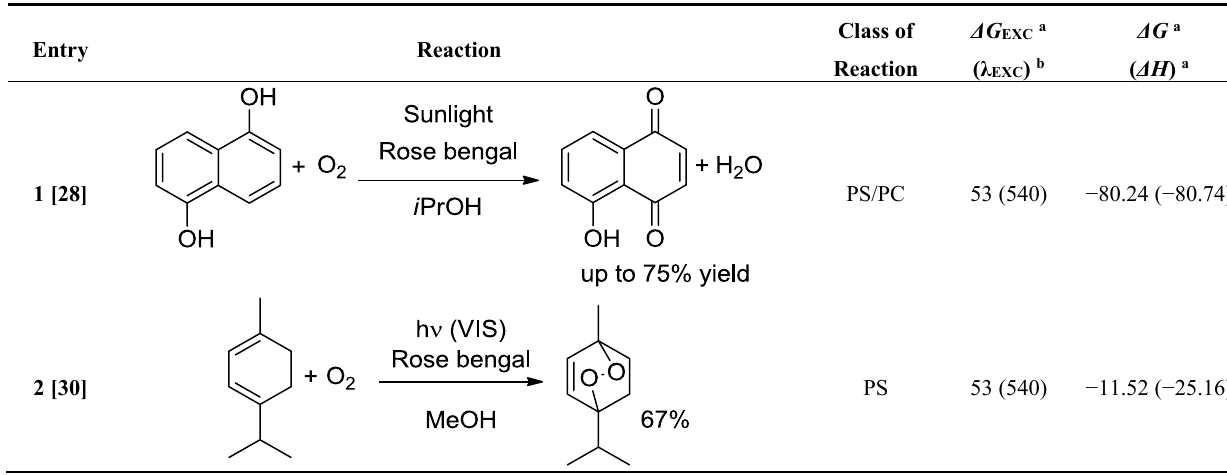
Table 1. Calculated thermodynamic parameters at the G3(MP2)B3 level of theory